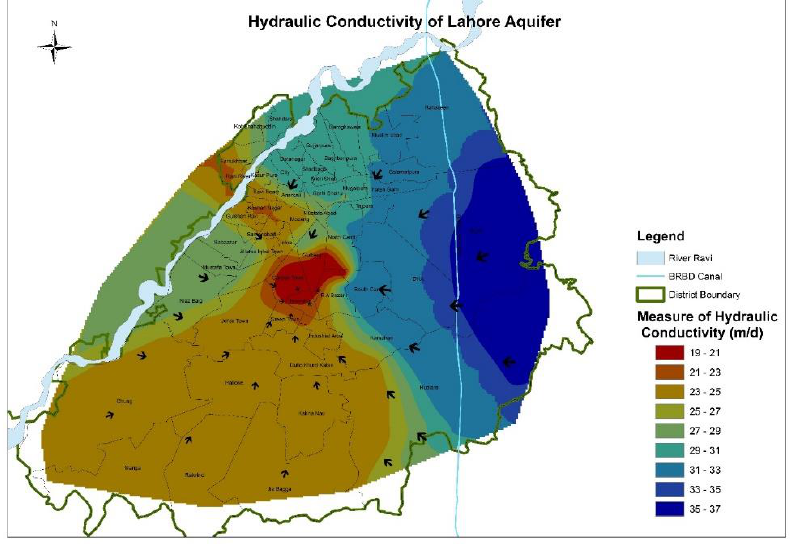
Figure 11. Hydraulic conductivity map of Lahore aquifer.